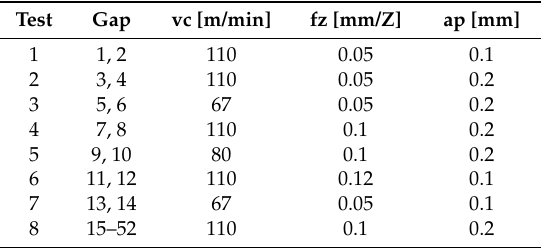
Table 7. Test parameters on hard machining test 1.